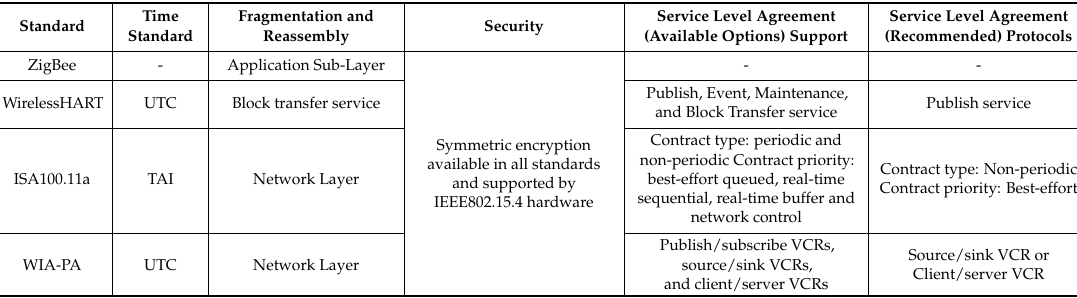
Table 4. Network transport